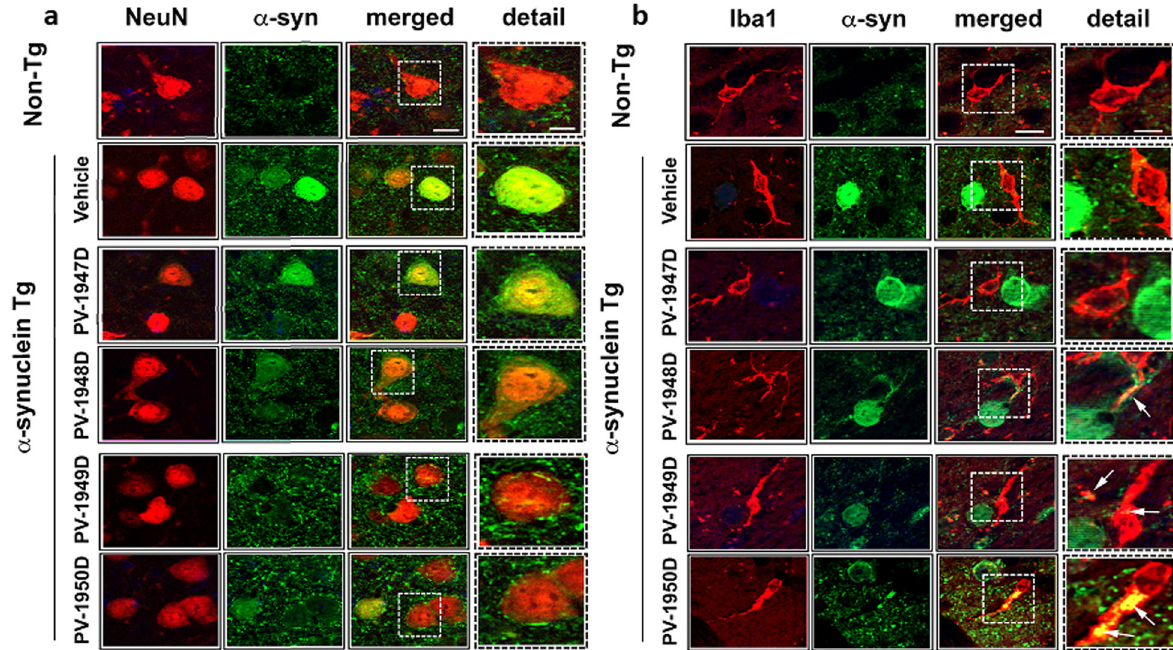
Fig. 9 Immuno fl uorescence analysis of double-labeled brain sections. Less accumulation of h α -syn in NeuN-positive neurons ( a ) and a closer opposition of microglia to the neuronal α -syn aggregates ( b ) in mice vaccinated with PV-1948D, PV-1949D, and PV-1950D was observed compared with PV-1947 vaccinated and control mice. The scale bar is10 μ m in the solid box and 5 μ m in the dotted